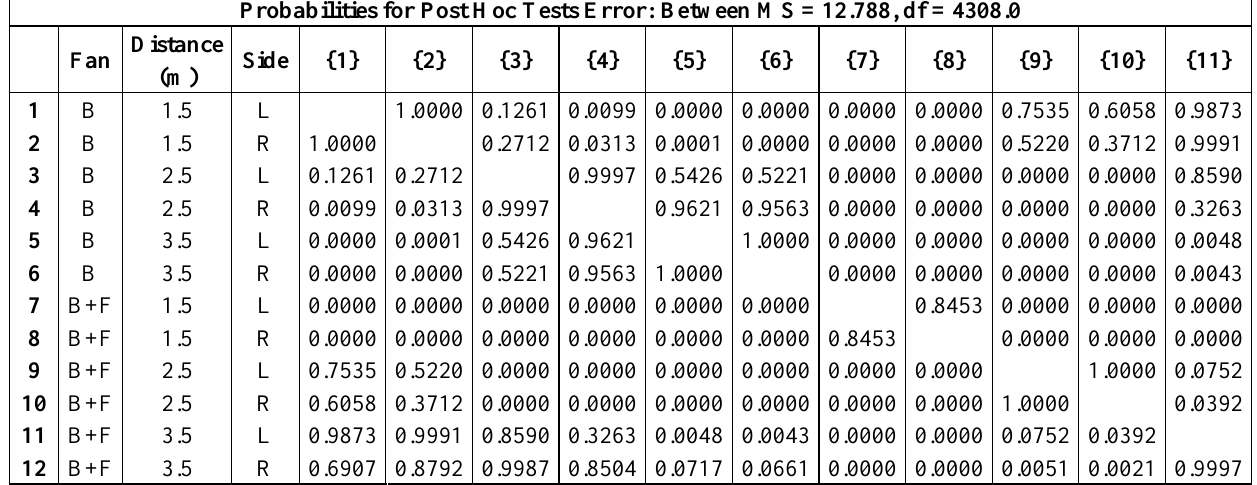
Table 4. Tukey HSD test; dependent variable: air velocity (m/s). Independent